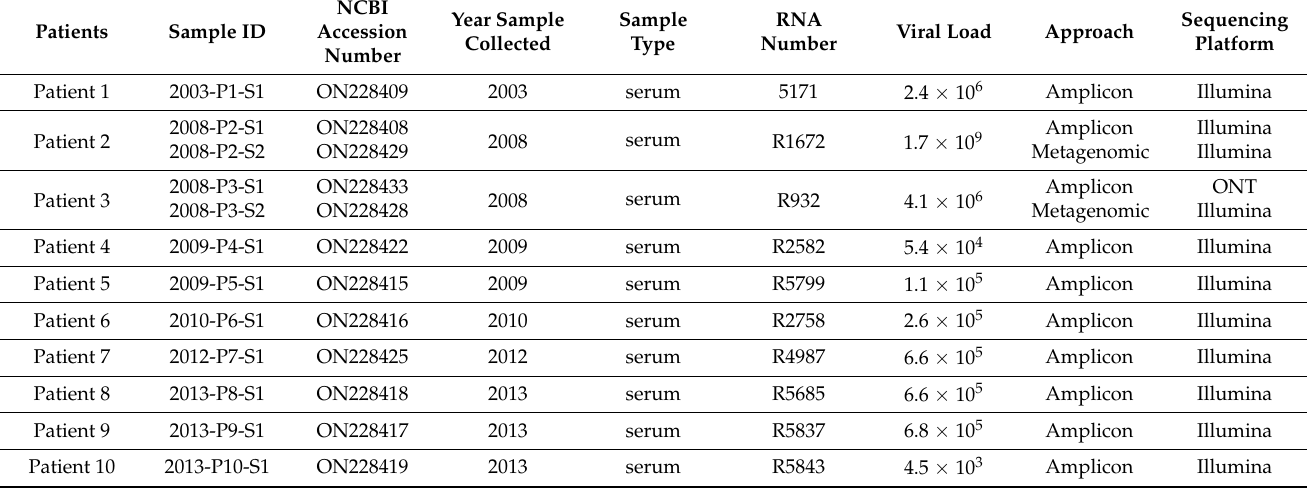
Table 1. Detailed information on patients and samples included with corresponding viral load and NCBI accession